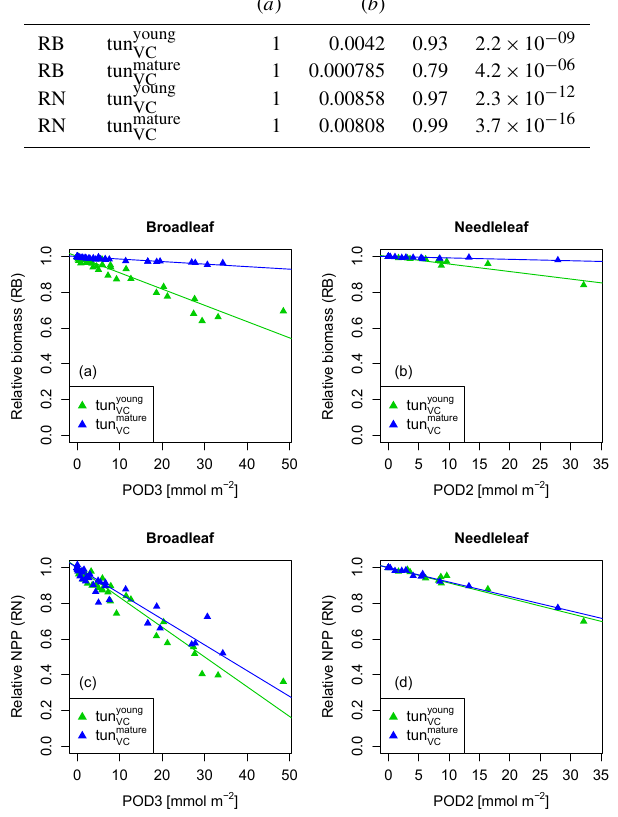
Figure 4. Biomass (RB) and NPP (RN) dose–response relationships of simulations with young (tun young separately for (a, c) broadleaf species and (b, d) needleleaf